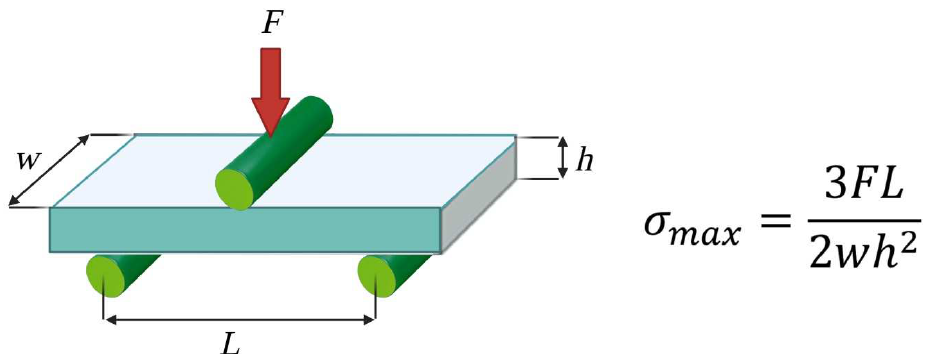
Figure 2. Description of static mechanical tests. The samples were placed on two support anvils and bent through an applied force on one or two anvils to measure their stress–strain data. The beam was proportioned so that it did not fail through shear or by lateral deflection before reaching its ultimate flexural limit. The equation reported for the highest stress at the moment of rupture was employed, where F = the load at the bar centre, L = the distance between the two lower supports, w = the width of the specimen, and h = the thickness of the specimen.